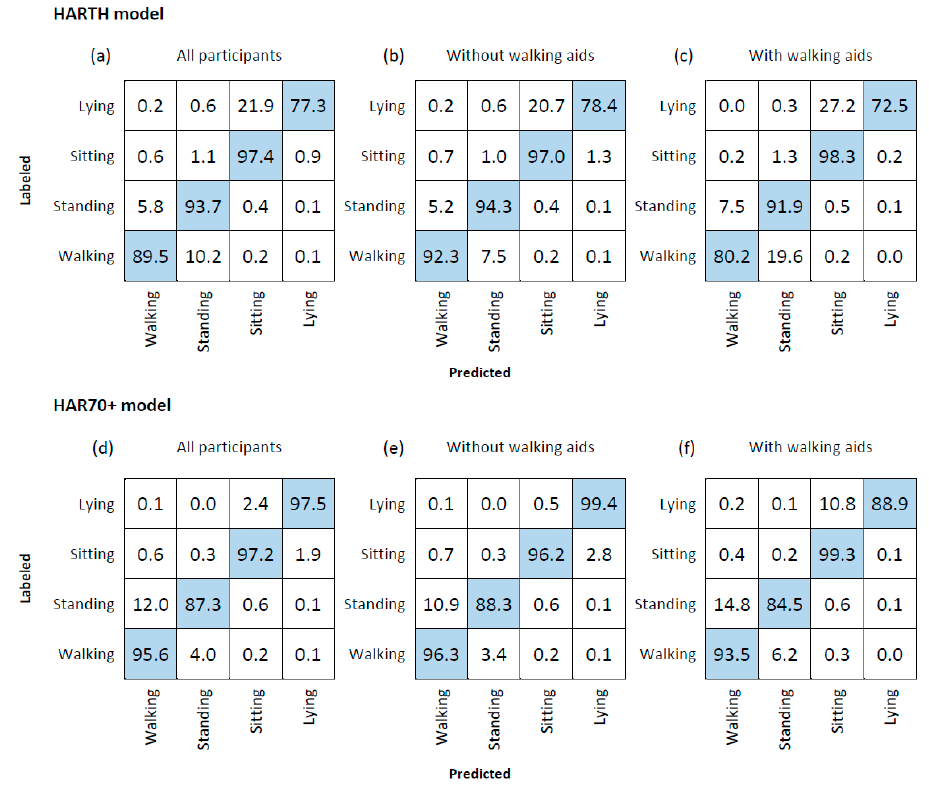
Figure 4. Confusion matrixes for the Human Activity Recognition Trondheim (HARTH) model ( a – c ) and the Human Activity Recognition 70+ (HAR70+) model ( d – f ) for all participants (n = 18) and separated for participants not using walking aids (n = 13) ( b , e ), and participants using walking aids (n = 5) ( c , f ). The rows represent the labeled activity types, while the columns represent predicted activity types. Values are shown in row percentages.